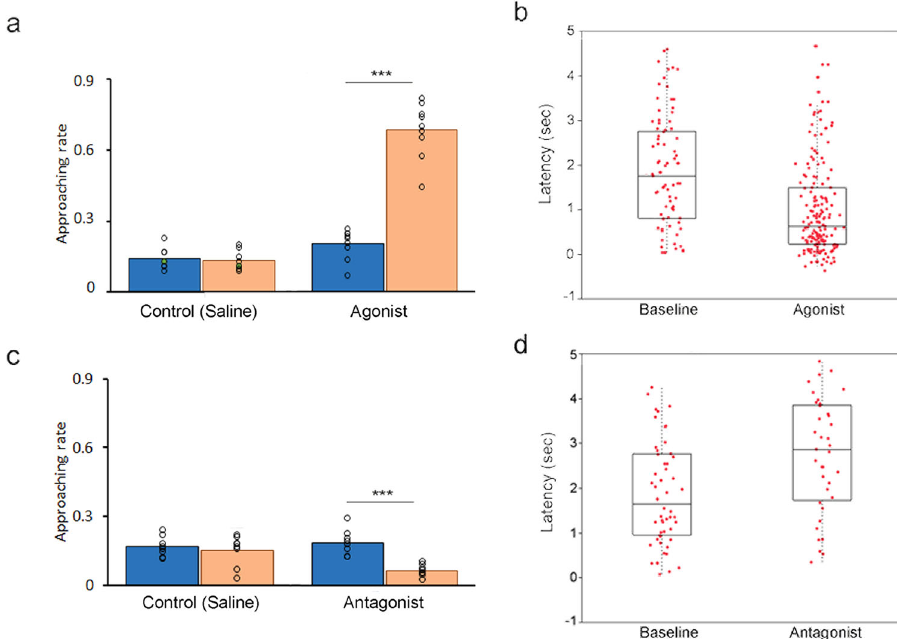
Fig. 3 The administration of dopamine agonist and antagonist had a signi fi cant effect on juvenile listening approaching behavior. a Subcutaneous administration of a dopamine agonist (nomifensine, 2.5 mg/kg) at 50 – 55 dph. Post-nomifensine-injected birds (orange bars with standard errors) showed a signi fi cantly increased approaching rate (# approaching movement/# tutor song) after the tutor sang, compared to the pre-injection period (blue bars with standard errors) or saline-injected controls ( n = 9 birds in nomifensine vs. 8 birds in the saline-injected group, Mann – Whitney U test, P < 0.001). b Post-nomifensine-injected birds approached their tutor more frequently and had an earlier onset (shorter latency) of approaching movement ( P < 0.001). Boxplots show the distribution of time latency to initiate approaching movement from nine post-nomifensine-injected birds. In each boxplot, the lines from the top to bottom were de fi ned as the third quartile, median, and fi rst quartile. Each red dot is one single recording of the approaching movement. Each individual ’ s post-nomifensine-injection response (approaching latency) can be seen in Supplementary Fig. 4. c Administration of a dopamine antagonist, SCH23390 (0.05 mg/kg; n = 9 birds), showed signi fi cantly inhibited attention and approaching behavior, compared to the saline injection ( n = 8 males, Mann – Whitney U test, U = 2.17, P < 0.001). d Post-SCH23390-injected juveniles showed signi fi cantly reduced approaching movement with greater latency to initiate the approaching